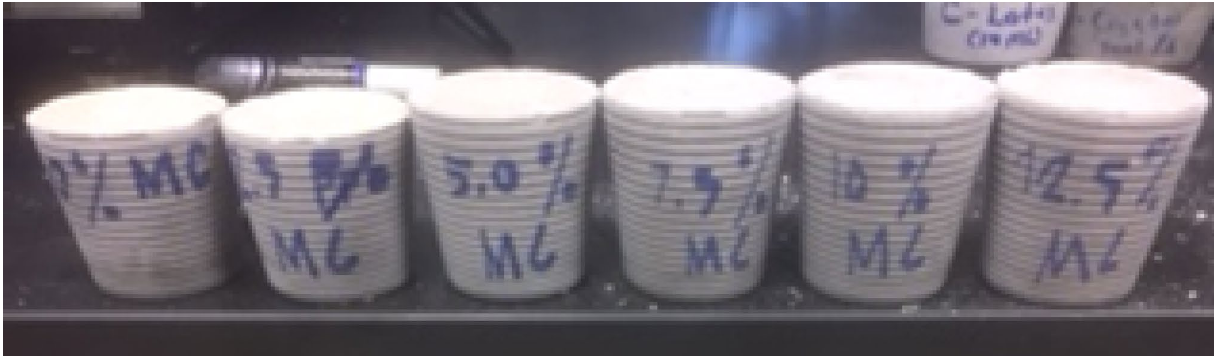
Fig. 10 Microbond sample at varying concentrations